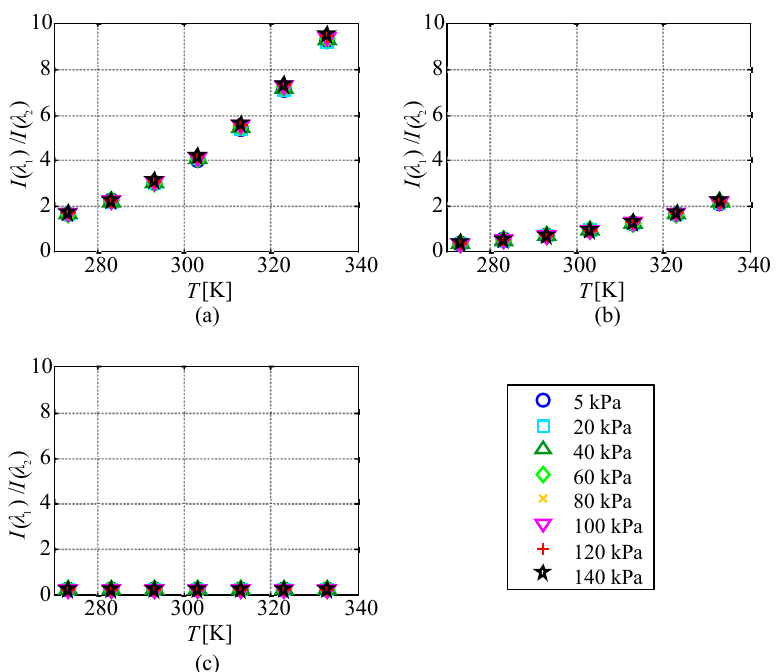
Figure 8. Temperature evolution of the ratio of the emission intensities of two wavelengths at each pressure.